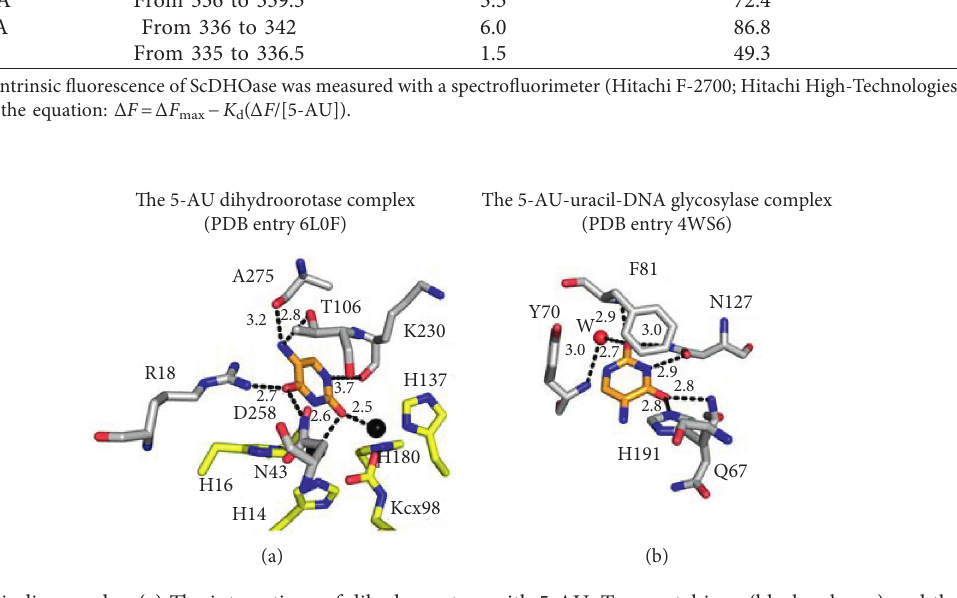
Figure 5: 5-AU binding modes. (a) The interactions of dihydroorotase with 5-AU. Two metal ions (black spheres) and the binding sites (gray) in dihydroorotase are involved in 5-AU (light orange) binding. (b) The interactions of uracil-DNA glycosylase with